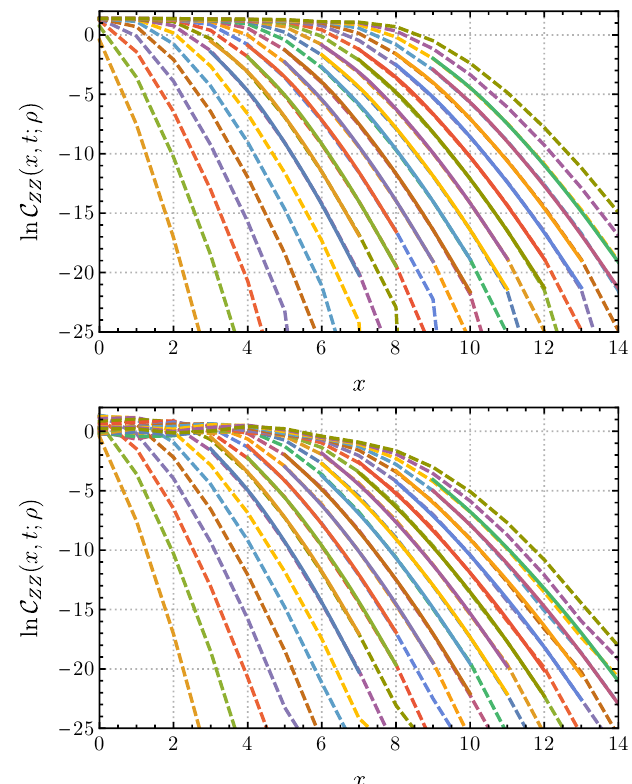
Figure 5: Examples of fitting. Dashed curves are from MPO numerics and fit- ting of (2) to wavefront is marked as solid. Each curve is ln C for a fixed = 1.05 J , h = 0 with J t = 0.2,0.4,...,4.8. The first plot is for β = 0 and h X Z = 1.95 Ja , p = 0.46 to be compared with exact values v = 2 Ja and a fitting v B B = 1.05 J , p = 0.5 ( a = 1 is the lattice spacing); the second plot is for β J = 3, h X = 0.3 J and the best fitting is v = 1.39 Ja with p = 0.65. h Z B